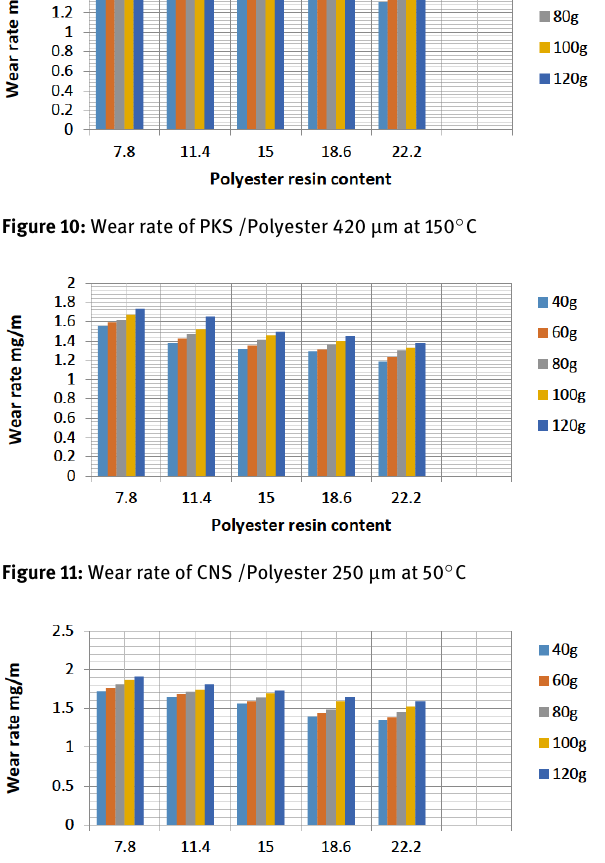
Figure 12: Wear rate of CNS /Polyester 250 µ m at 150 ∘ C